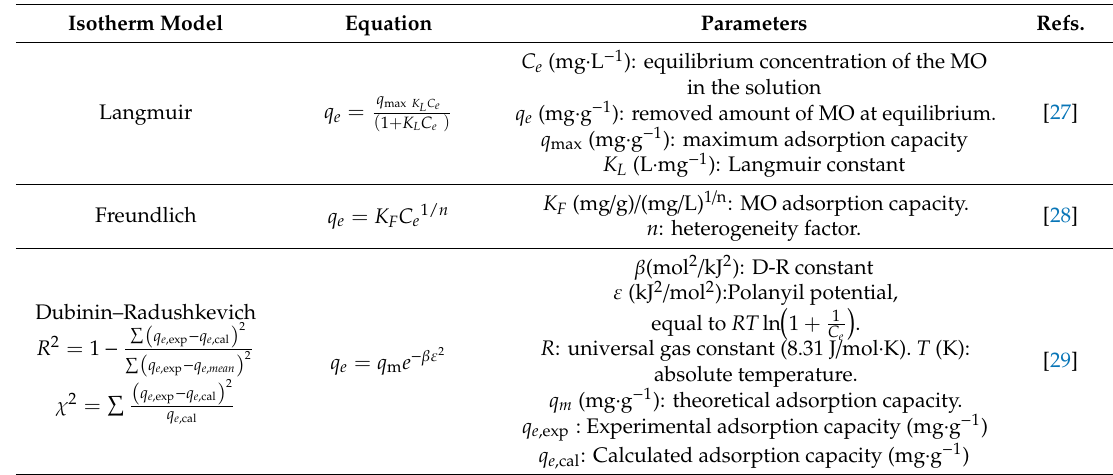
Table 3. Isotherms models used to fit the adsorption of MO on adsorbent Mn – mica. Isotherm Model Equation Parameters Refs. Langmuir [27] Freundlich